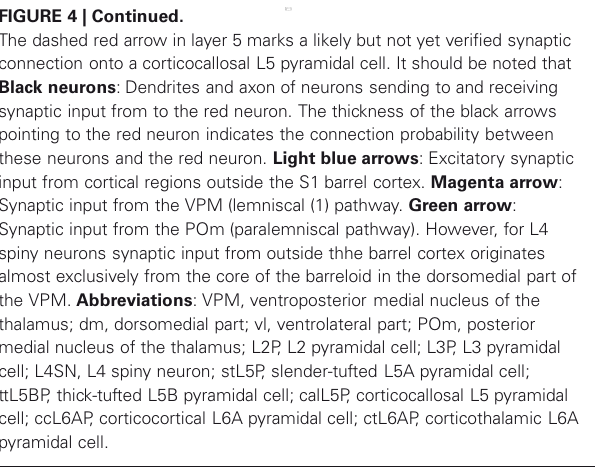
FIGURE 4 | Continued. The dashed red arrow in layer 5 marks a likely but not yet verified synaptic connection onto a corticocallosal L5 pyramidal cell. It should be noted that Black neurons : Dendrites and axon of neurons sending to and receiving synaptic input from to the red neuron. The thickness of the black arrows pointing to the red neuron indicates the connection probability between these neurons and the red neuron. Light blue arrows : Excitatory synaptic input from cortical regions outside the S1 barrel cortex. Magenta arrow : Synaptic input from the VPM (lemniscal (1) pathway. Green arrow : Synaptic input from the POm (paralemniscal pathway). However, for L4 spiny neurons synaptic input from outside thhe barrel cortex originates almost exclusively from the core of the barreloid in the dorsomedial part of the VPM. Abbreviations : VPM, ventroposterior medial nucleus of the thalamus; dm, dorsomedial part; vl, ventrolateral part; POm, posterior medial nucleus of the thalamus; L2P, L2 pyramidal cell; L3P, L3 pyramidal cell; L4SN, L4 spiny neuron; stL5P, slender-tufted L5A pyramidal cell; ttL5BP, thick-tufted L5B pyramidal cell; calL5P, corticocallosal L5 pyramidal cell; ccL6AP, corticocortical L6A pyramidal cell; ctL6AP, corticothalamic